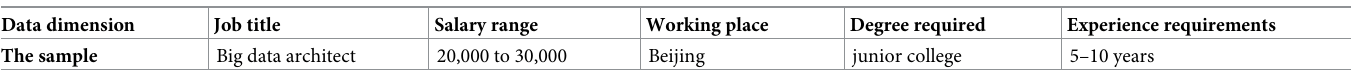
Table 1. Shows the collected